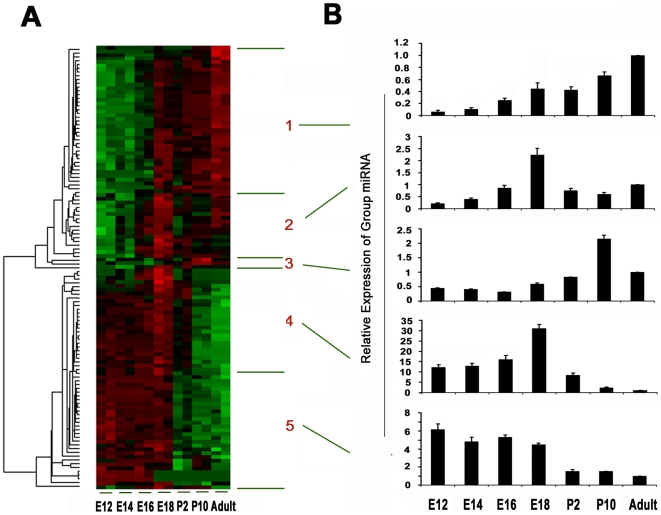
Temporal expression patterns of miRNA using hierarchical cluster analysis.(A) 5 temporal expression patterns represented by color heat maps. (B) 5 temporal expression patterns represented by bar graphs (x axis indicating the 7 time points, y axis indicating the relative expression values of group miRNAs). With miRNA copy number as an miRNA expression value, The relative expression values in each time point are the ratios normalized against those in the Adult group.